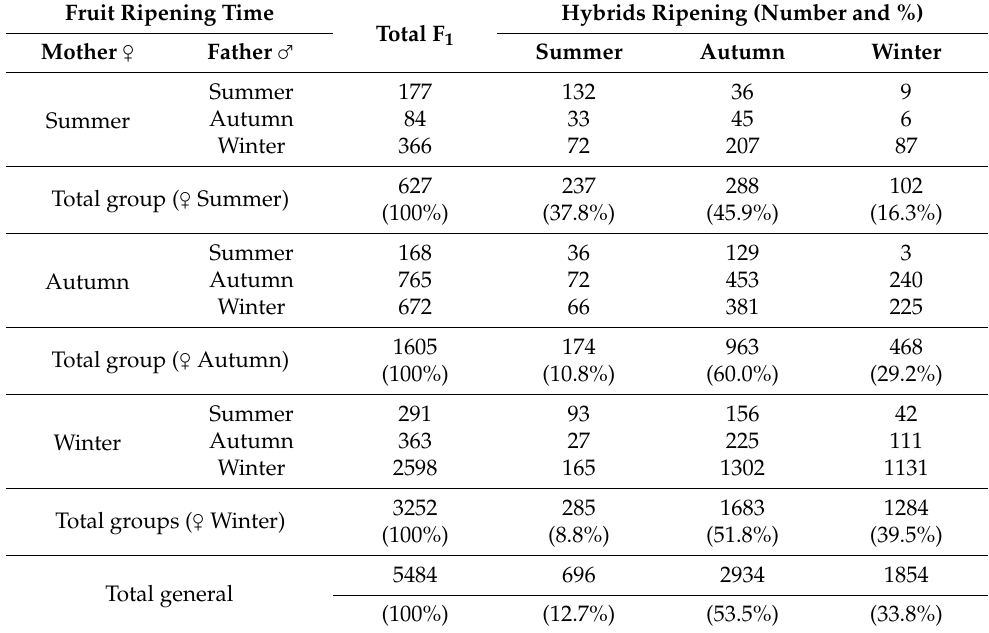
Table 6. Classification of F 1 hybrids from all hybridizations into three classes depending on the fruit ripening time according to parents and their crosses